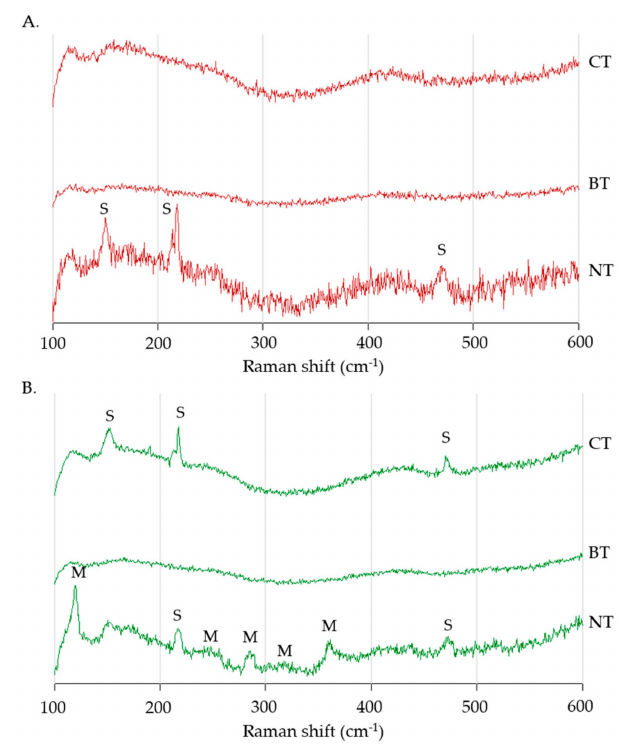
Figure 4. Raman spectra obtained on A . set B (fresh oak) and B. set E (fresh pine) untreated (NT), biologically treated (BT) and chemically treated (CT); with sulfur (S) and partially oxidized mackinawite (M) characteristics shifts indicated.